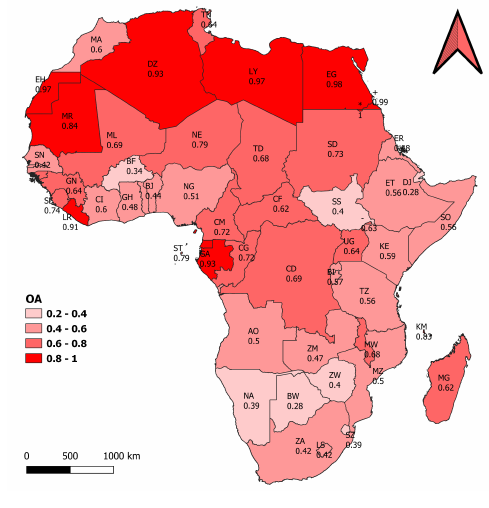
Figure 1. OA per country